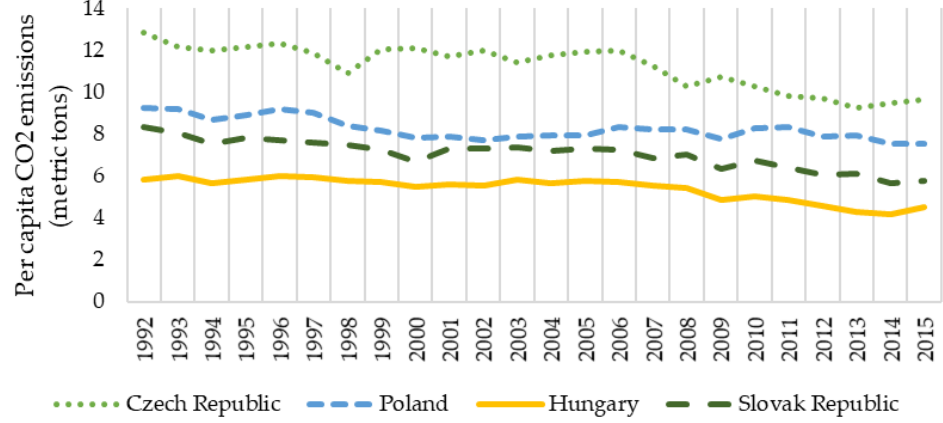
(Figure 3). Figure 2. A plot of CO 2 emissions per capita for V4 countries in 1992–2015. Figure 2. A plot of CO 2 emissions per capita for V4 countries in 1992 – 2015.